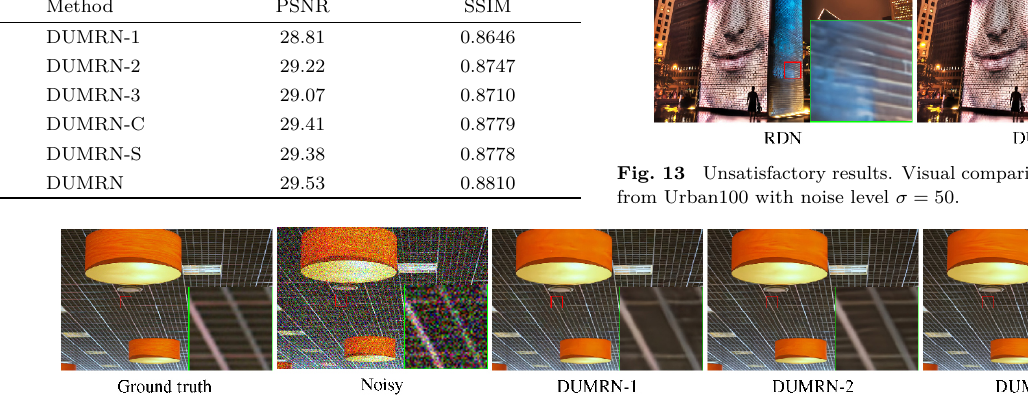
Fig. 11 Effectiveness of the MSRB on image denoising. Visual comparison on image img 044 from Urban100 with noise level σ =